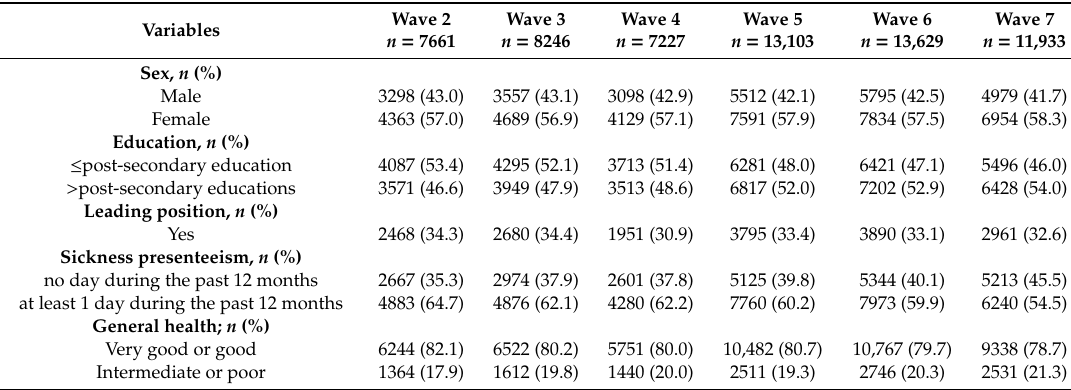
Table 1. Characteristics of the study participants at wave 2 (2008)–wave 7